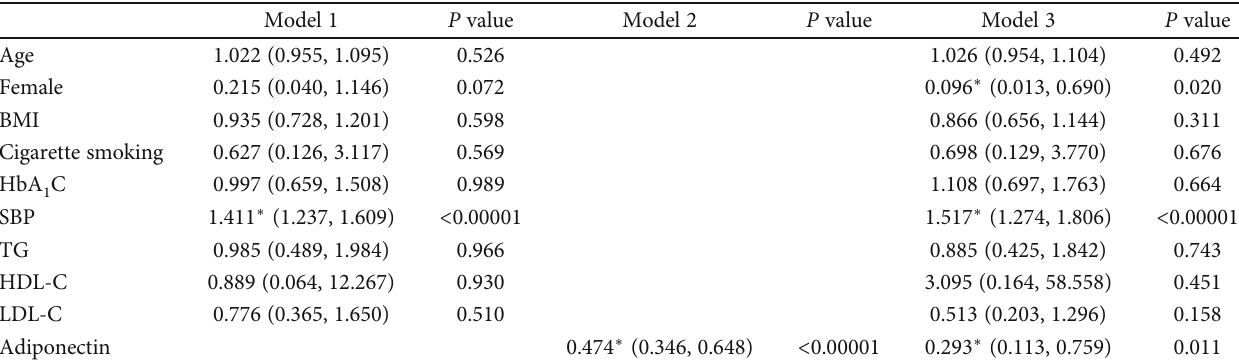
Table 5: The odds ratio of risk factors for diabetic macroangiopathy participants versus nondiabetic macroangiopathy participants.